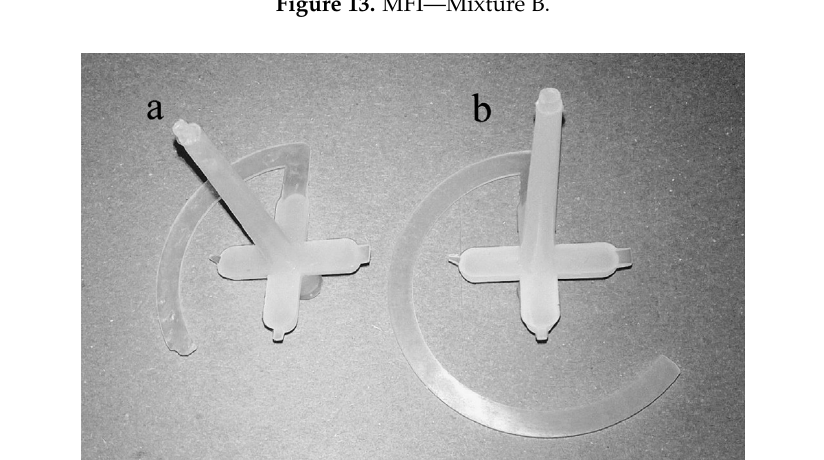
Figure 13. MFI—Mixture B.